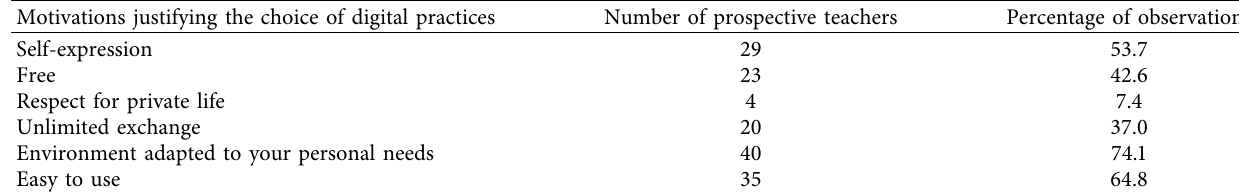
Table 5: The different motivations for choosing between digital